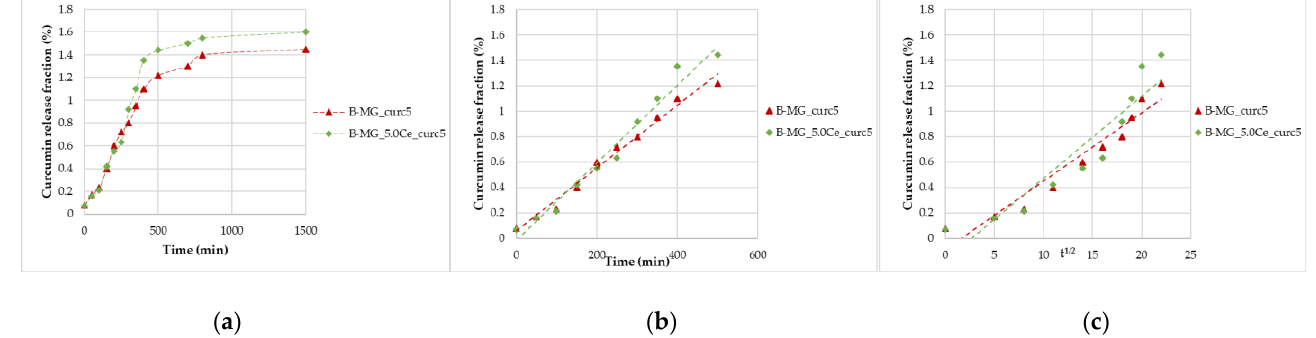
Figure 6. Curcumin release kinetics from B-MGs in SBF; ( a ) curcumin fraction released in the first 24 h for the two samples B-MG_curc5 and B-MG_5.0Ce_curc5; ( b ) linearization according to Peppas’ model (n = 1); and ( c ) linearization according to Higuchi’s model ( n = 0.5). From the collected data, a release of 3.0 – 3.1 µmol of curcumin per 100 mg of beads